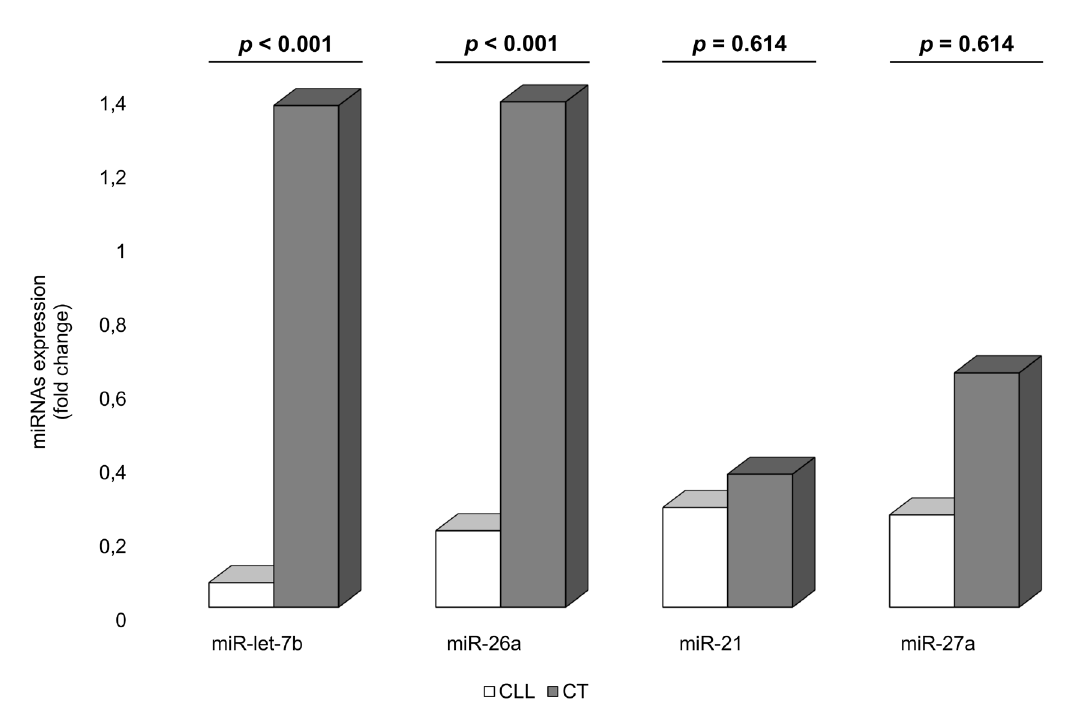
FIGURE 2 - Median values of gene expression of each miRNA according to CLL patients as a whole and controls; CLL: Chronic Lymphocytic Leukemia; CT: Controls.